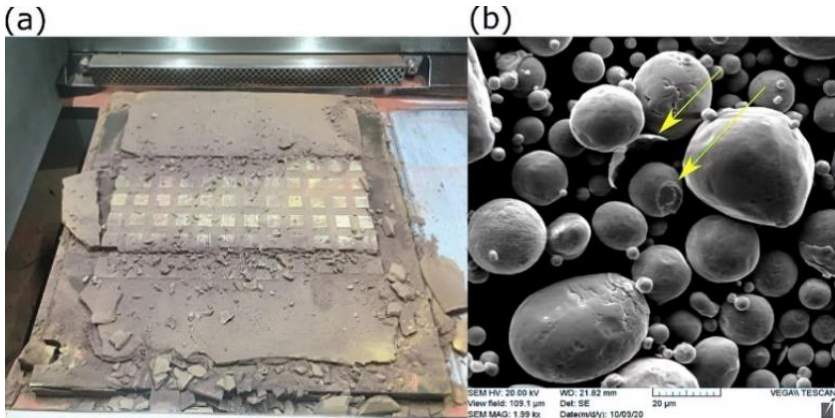
Figure 13. Solid-state sintering of Cu powder at elevated preheating temperature: ( a ) in-field image after printing, and ( b ) SEM of recycled powder (sieved).